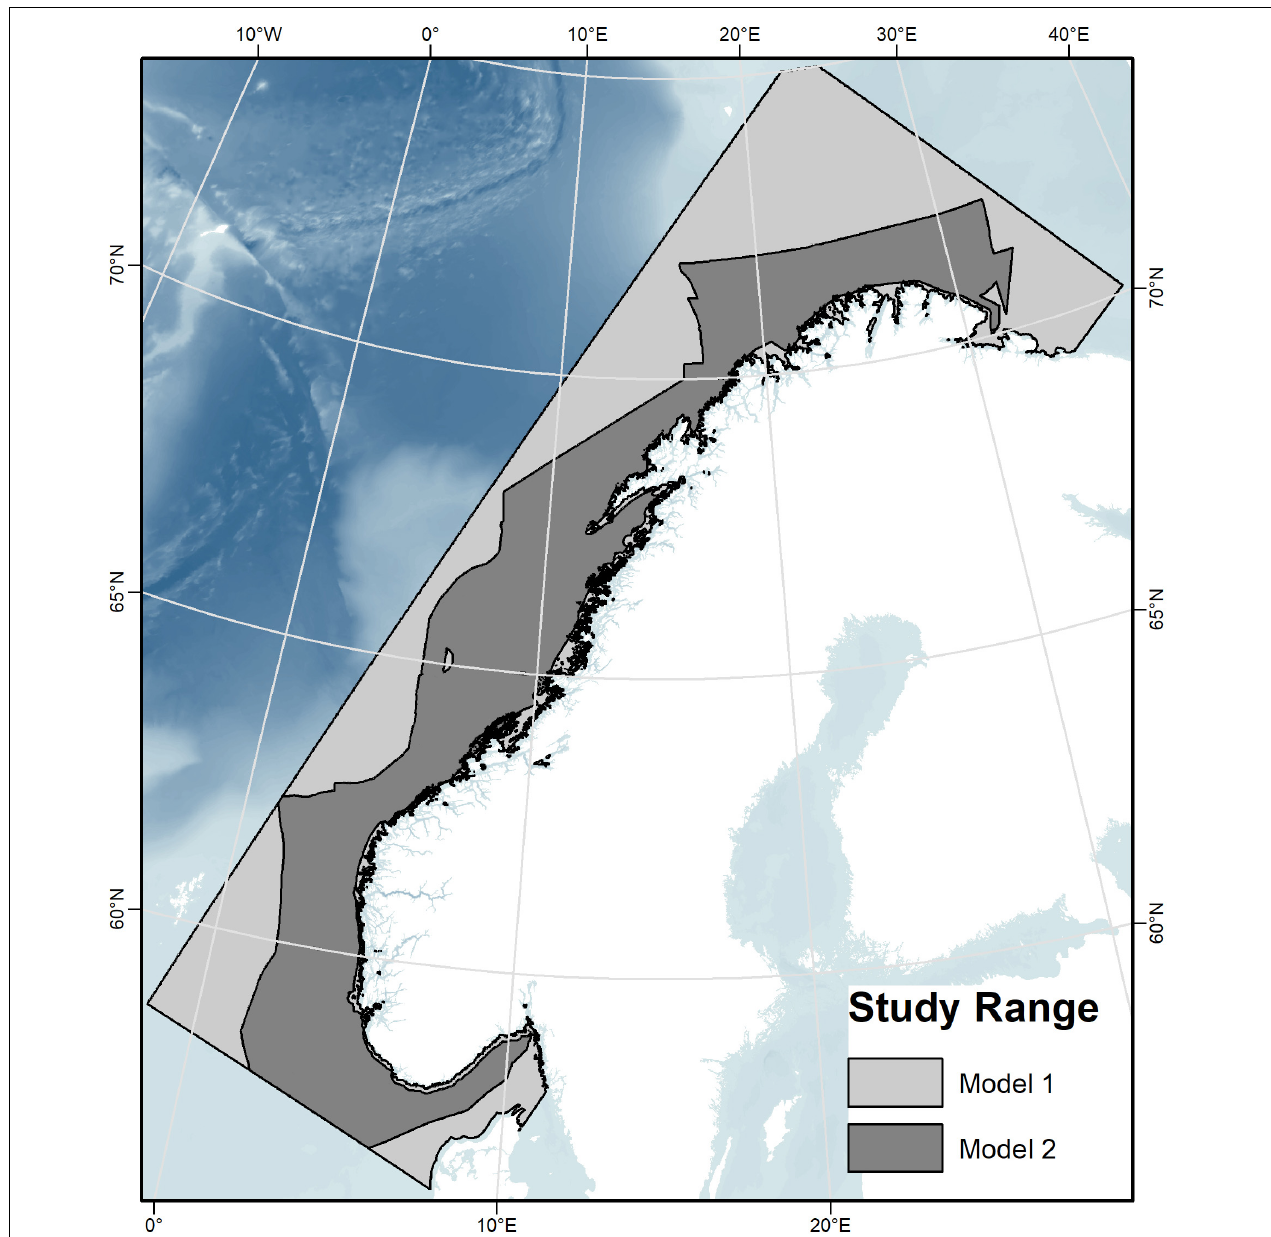
FIGURE 3 | The study area showing the geographic extent of the two models. The light-gray polygon (Model 1) indicates the full study area, without full-areal coverage of the sediment and marine landscape environmental variables, and the dark-gray polygon (Model 2) superimposed on Model 1 indicates the more restricted area with all variables, including sediment and marine